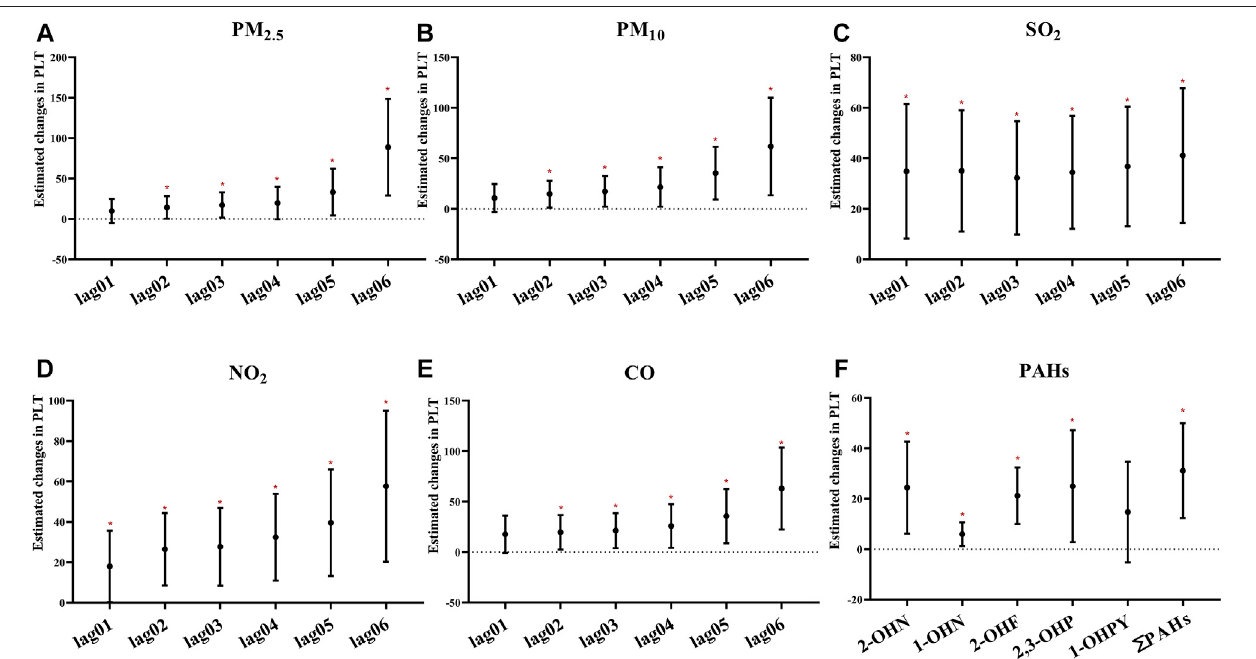
FIGURE 4 | Estimated changes (95% con fi dence intervals) of PLT in the thrombocyte parameters. Changes (95% con fi dence intervals) in the biomarkers with IQR increases in air pollution indicators were calculated, respectively, at different time lags (days). (A – E) Indicates the situation of each pollutant separately. (F) Indicates the estimated changes (95% con fi dence intervals) in the thrombocyte parameters with IQR increases of PAHs. Models adjusted for age, BMI, height, and smoking status. Red * denotes p <